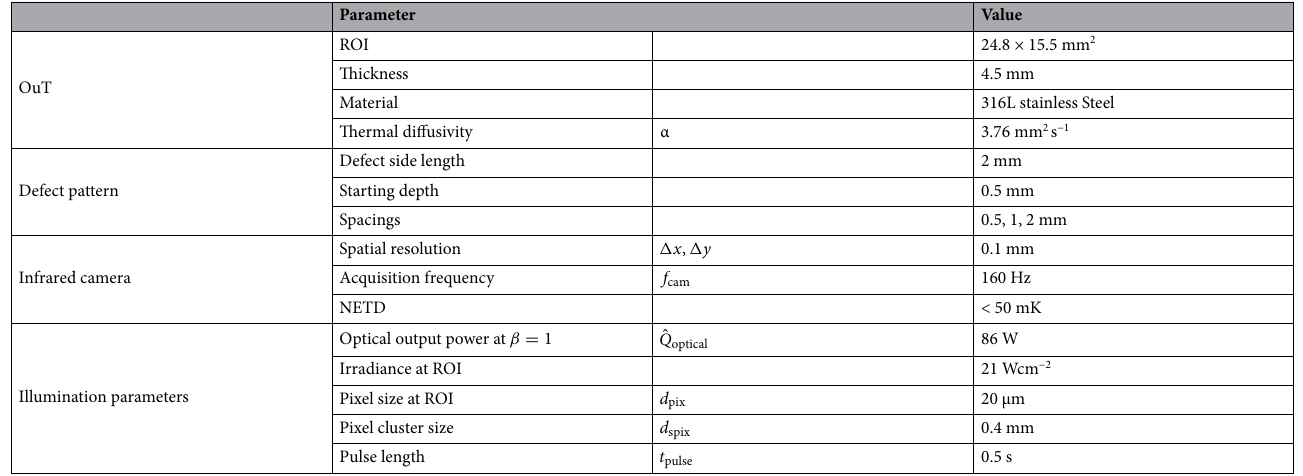
Table 1. Overview over the experimental